Question: From the figure, is the trend upward or downward?
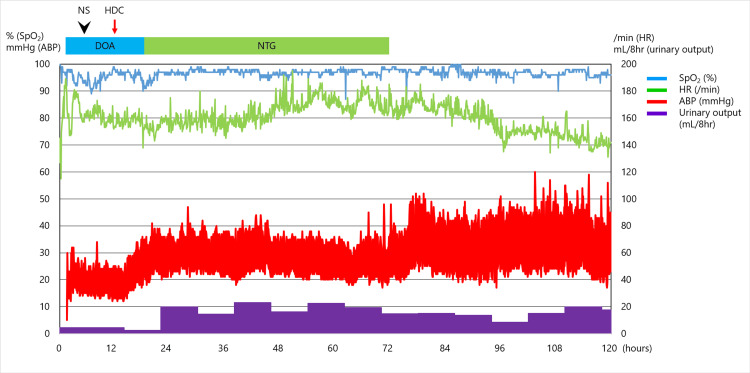
Answer: increasing